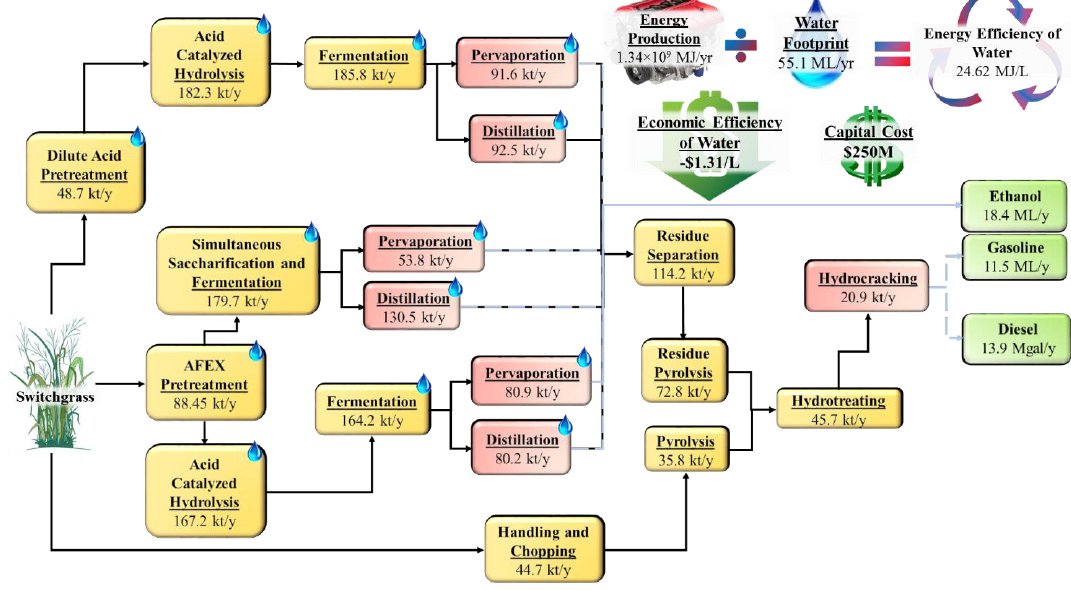
Figure 4. Optimal processing pathway, water footprint, economic efficiency of water, overall capital cost, and energy efficiency of water of the minimum water footprint solution. A water drop over a technology in the pathway denotes process water recycling is incorporated in the input process